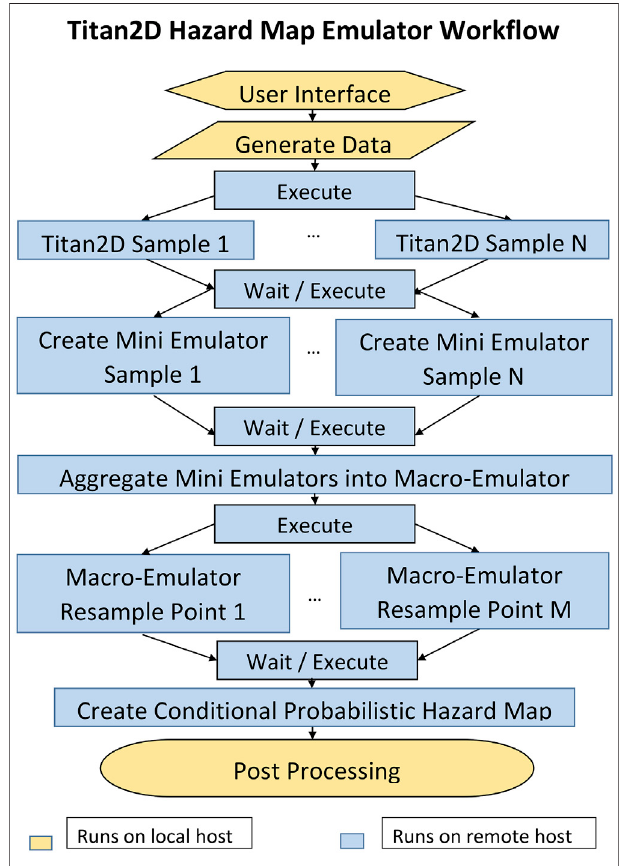
FIGURE 3 | Titan2D hazard map work fl ow tasks for pyroclastic fl ows and other sur fi cial mass fl ows. Pegasus monitors the completion of task executionsbydeterminingwhenrequiredoutput fi